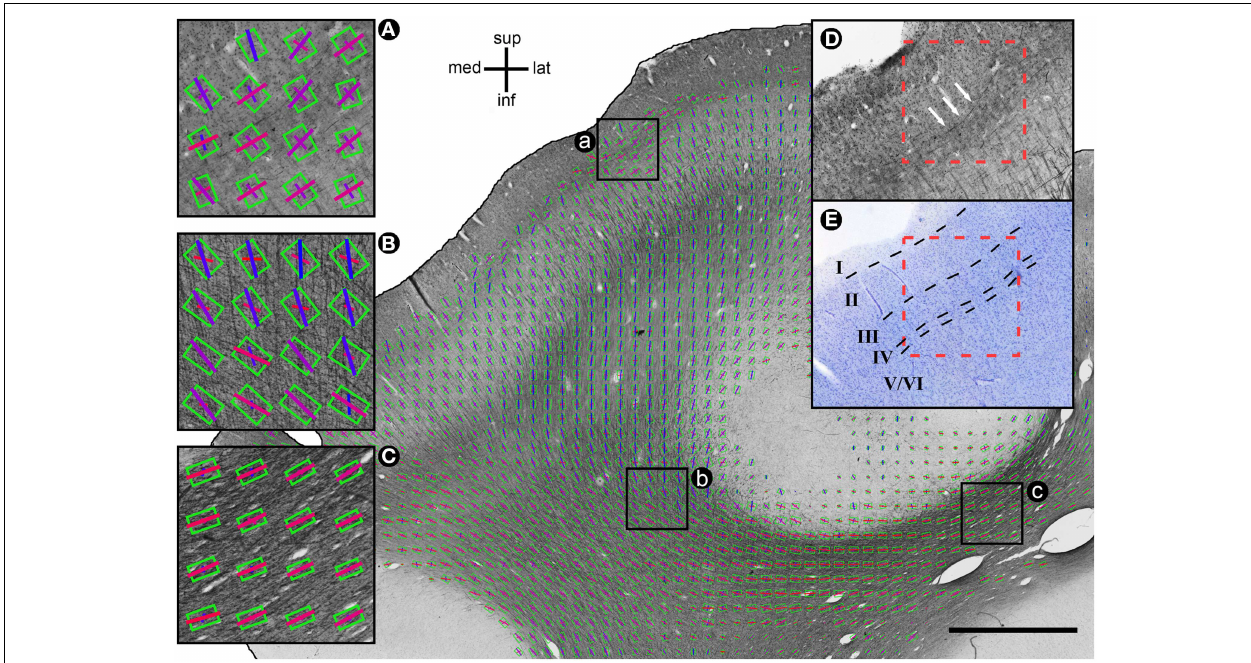
FIGURE 3 | Exemplary histological section with MRI DT and Hist ST orientations. Diffusion tensors are coded by oriented green rectangles, where rectangle aspect ratio indicates fractional anisotropy (more elongated = higher FA). Hist ST orientations are coded by bars. The color of the bars indicates the respective orientation (lateral-medial = red; inferior-superior = blue). Size of DT rectangles and ST bars is proportional to DT projection length. Scale bar: 3mm. (A) Voxels in which myelin orientations are parallel to the cortical surface, DT